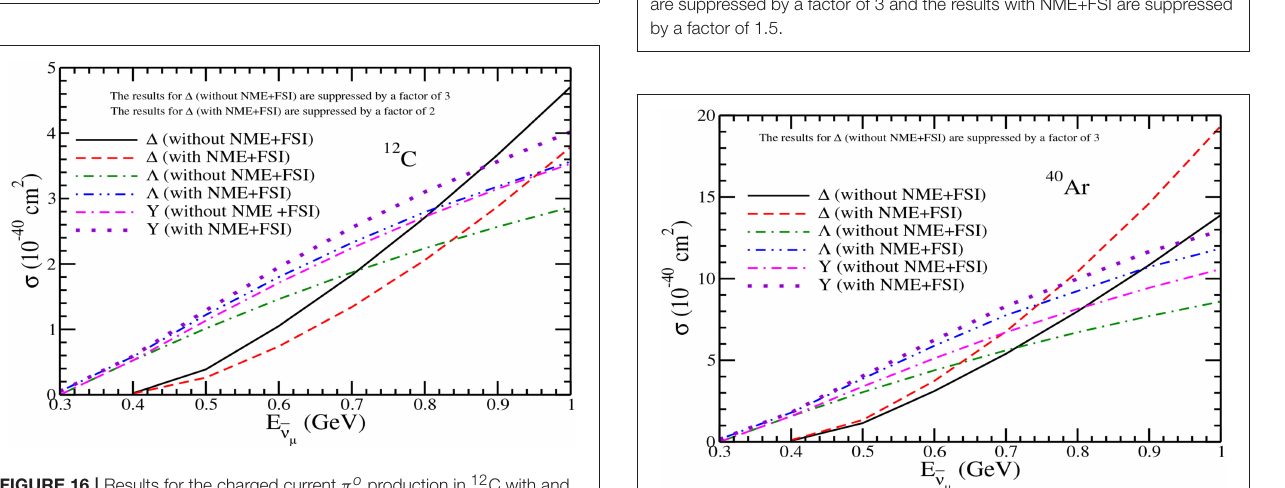
FIGURE 15 | Results for π − production in 208 Pb. Lines and points have the same meaning as in Figure 12 . Notice that the results of 1 without NME+FSI are suppressed by a factor of 8 and the results with NME+FSI are suppressed by a factor of 2 to bring them on the same scale.